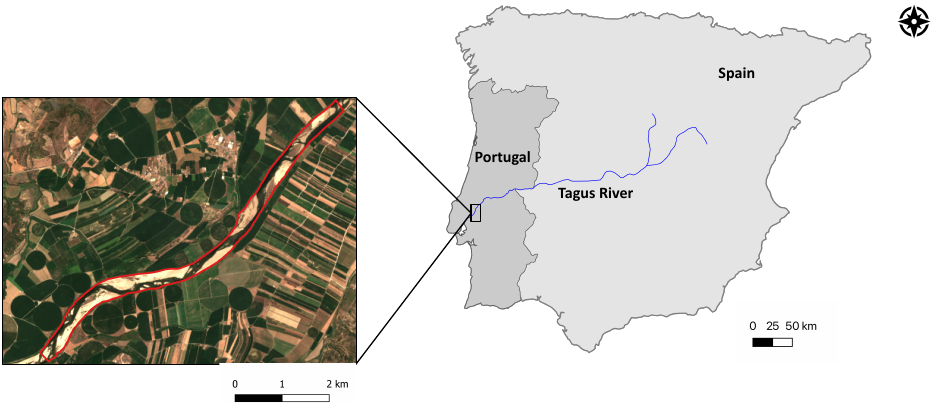
Figure 1. Identification of the river segment investigated in this study ( left ) and its location in the Tagus River ( right ). The view of the river segment, which captured a condition of very low river discharge that occurred in the summer of 2022, reveals the extensive presence of sandbars along the river